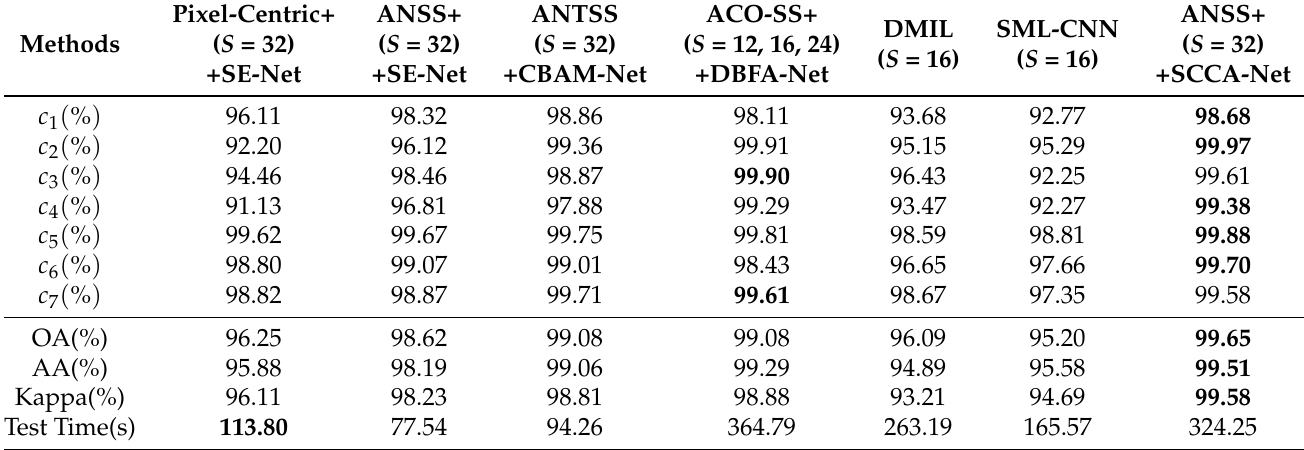
Table 7. Quantitative Classification Results of Xi’an Urban area